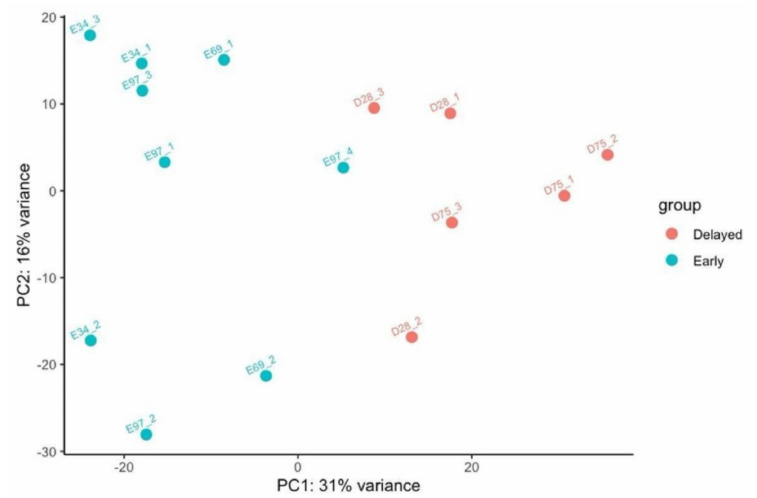
Figure 1. PCA biplot showing coordinates of early and delayed flowering guar lines according to the expression level of 78,015 transcripts which corresponds to the longest isoforms. For each line, three different plants were assessed for gene expression level. Plant ID (Table 1) is prefixed with E (Early) or D